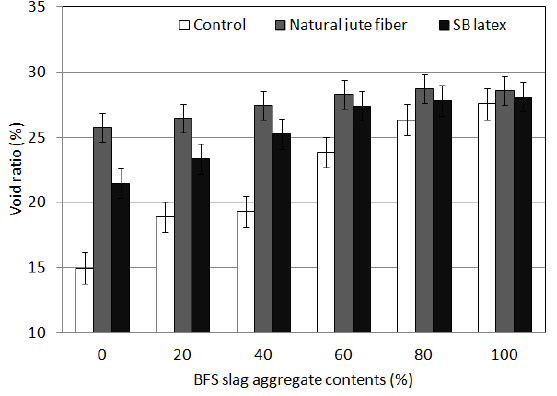
Figure 3. Void ratio results of porous concrete for plant growth.